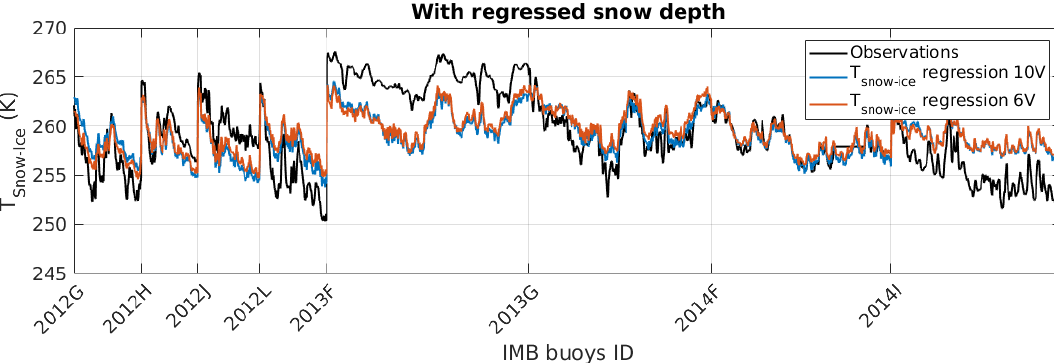
Figure 9. Same as Fig. 8, using the regressed snow depth (Eq. 2) in place of in situ snow depth